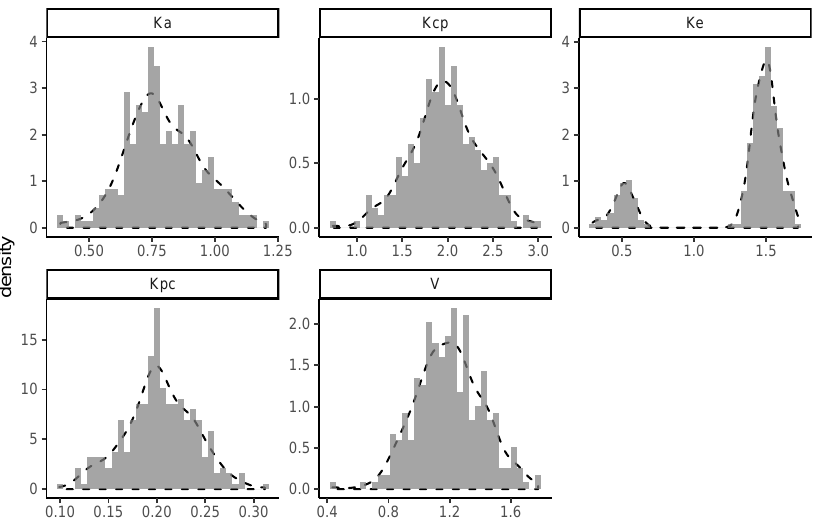
Figure A3. Kernel densities of simulated PK parameters. All K are in Hr − 1 , Volume is in dL . Kernel density (dashed line) of the distribution is over-plotted on the histogram (grey), which are normalized to the total observations. Simulated support points are generated in Pmetrics using the function SIMrun() . Details are in the text. Kernel densities are calculated in R using the (S3) generic function density()